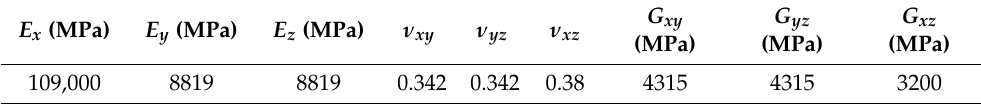
Table 2. CFRP elastic orthotropic properties [47].